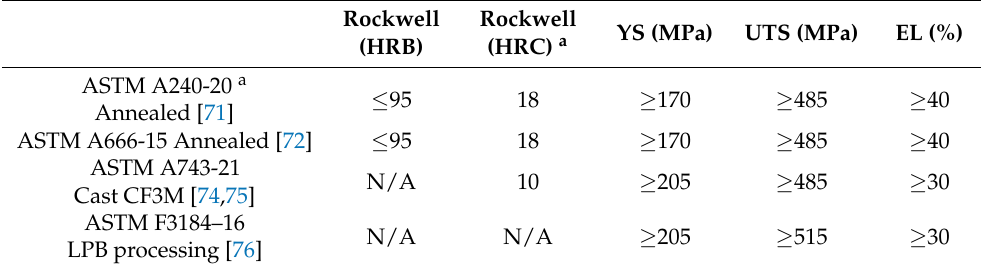
Table 4. Specification of the mechanical properties of 316LSS in ASTM